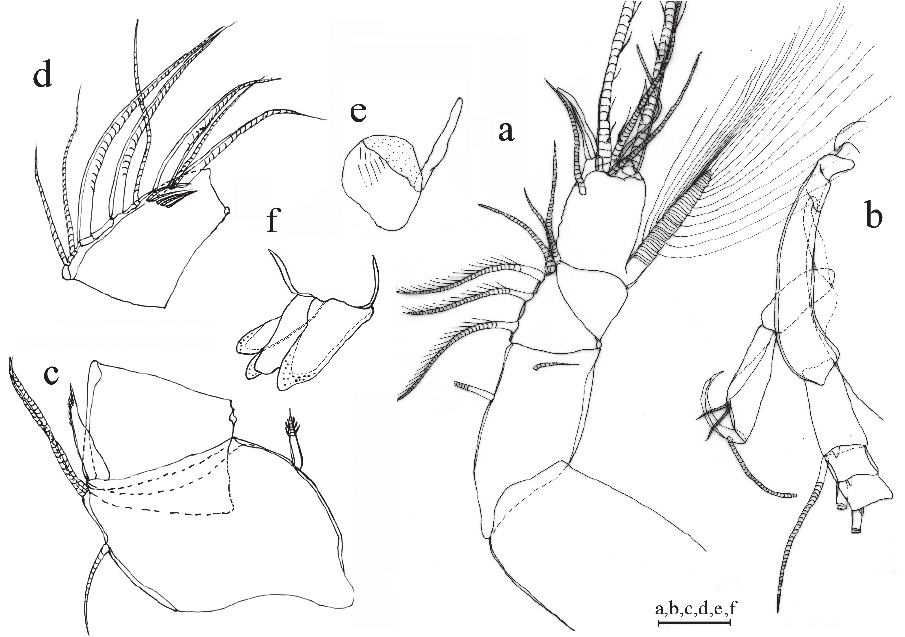
Figure 4. Parasterope busanensis sp. nov. paratype male adult: a A1 b A2 c Md d Bellonci organ. Scale bar: 0.1